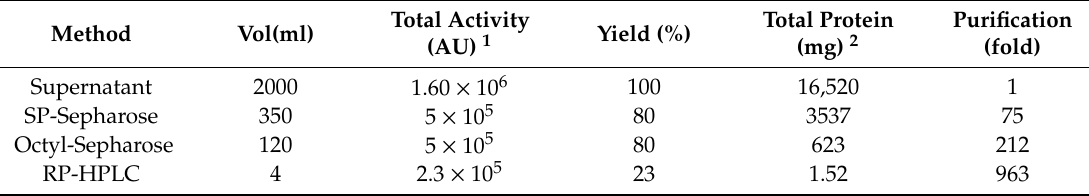
Table 2. Purification of pantocinwh-1 produced by Pantoea dispersa W18.